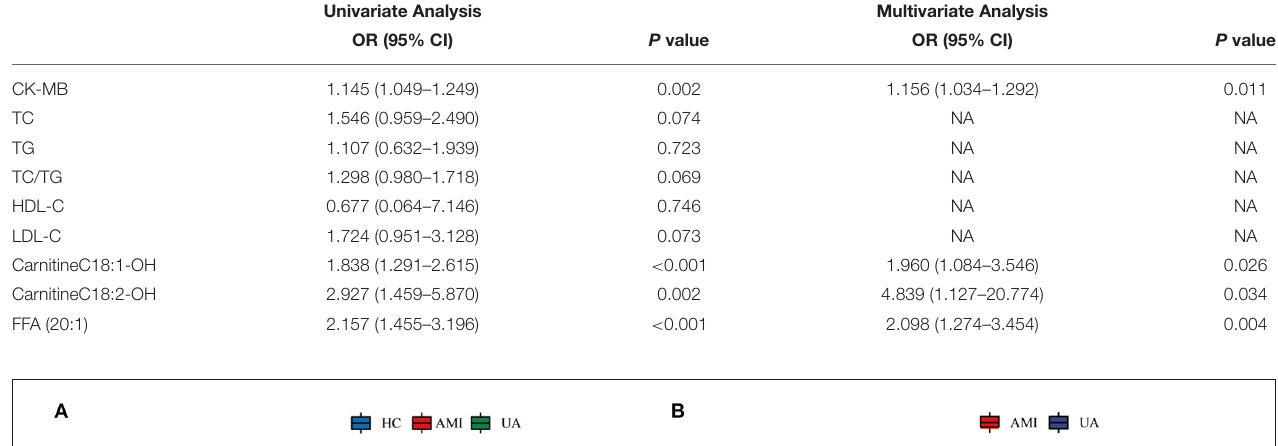
TABLE 3 | Univariate and multivariate logistic regression in validation set.